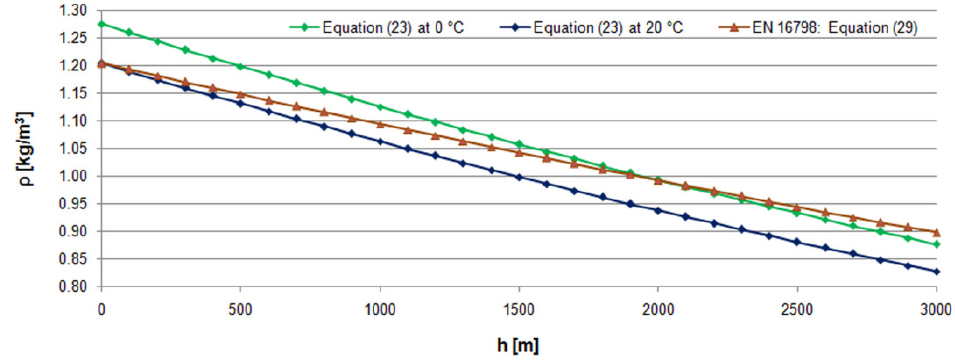
Figure 5. Dry air density variation as a function of altitude.